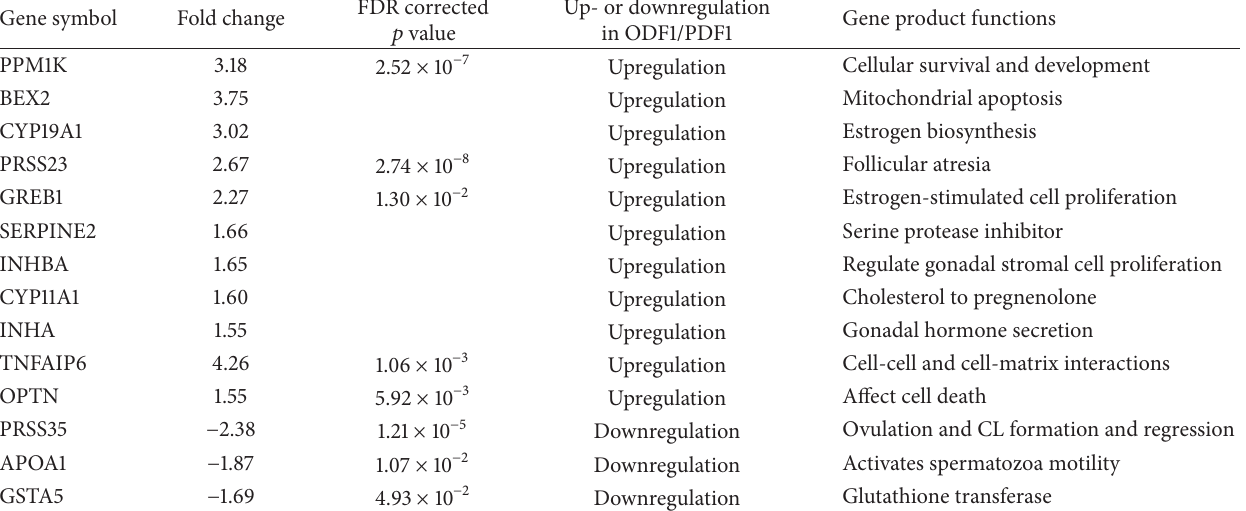
Table 5: Differentially expressed genes between ODF1 and PDF1 with known or predicted roles in follicular development. Gene